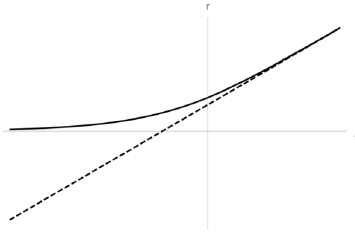
Figure 13. The cigar wrapping saddle. When j = j N lies on the bound state spectrum eq. (3.9b), the reflection coefficient is singular, and it is the otherwise sub-leading term e − 2 jr in eq. (3.18) that describes the operator O jnw in the asymptotic region. The free field Green function, shown by the dashed line, maps the string out of the free field region and must be modified. The complete solution for | w | = 1 and n = 0 is θ = ± φ , r = sinh − 1 ( e ρ ) . The neighborhood of the bound state insertion wraps the tip of the cigar, with r → e ρ asymptotically approaching r = 0 . The leading saddle is independent of N , which enters in the sub-leading correction to the saddle-point